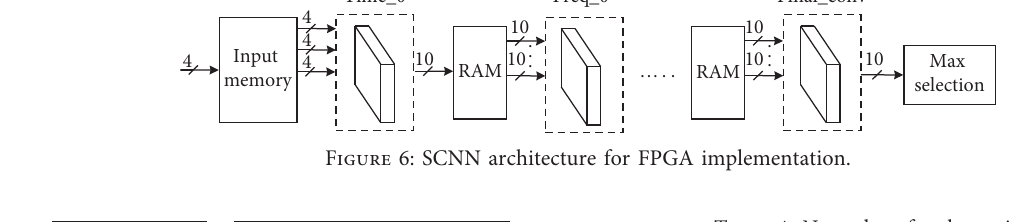
Table 4: N clk values for the various